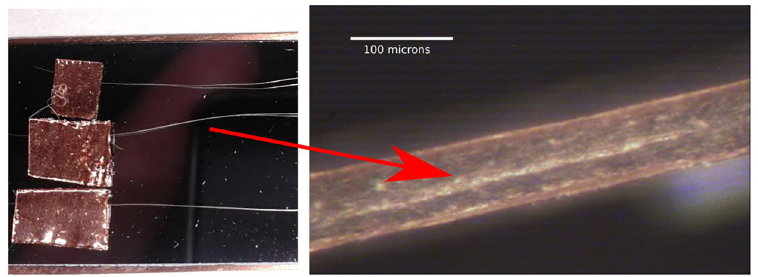
Fig 4. Left : Hair samples attached to a silicon wafer. Right : One of the samples as seen under the microscope.